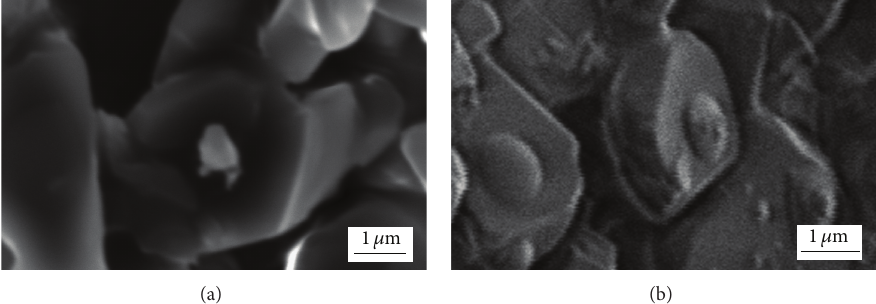
Figure 7: SEM micrographs of samples with 5wt% Ni loading: (a) chloride precursor for Ni on the foam surface and (b) Ni on the foam surface, obtained after reduction of chloride precursor at 633